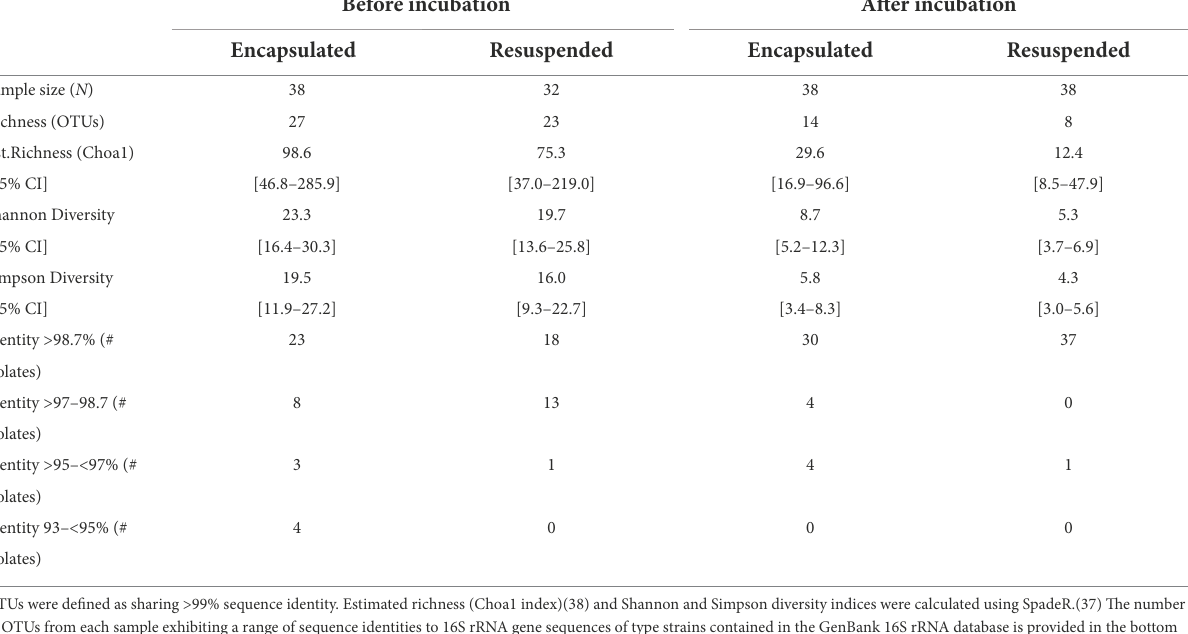
TABLE 1 Summary of the diversity obtained from two sediment treatments before and after in-situ incubation.